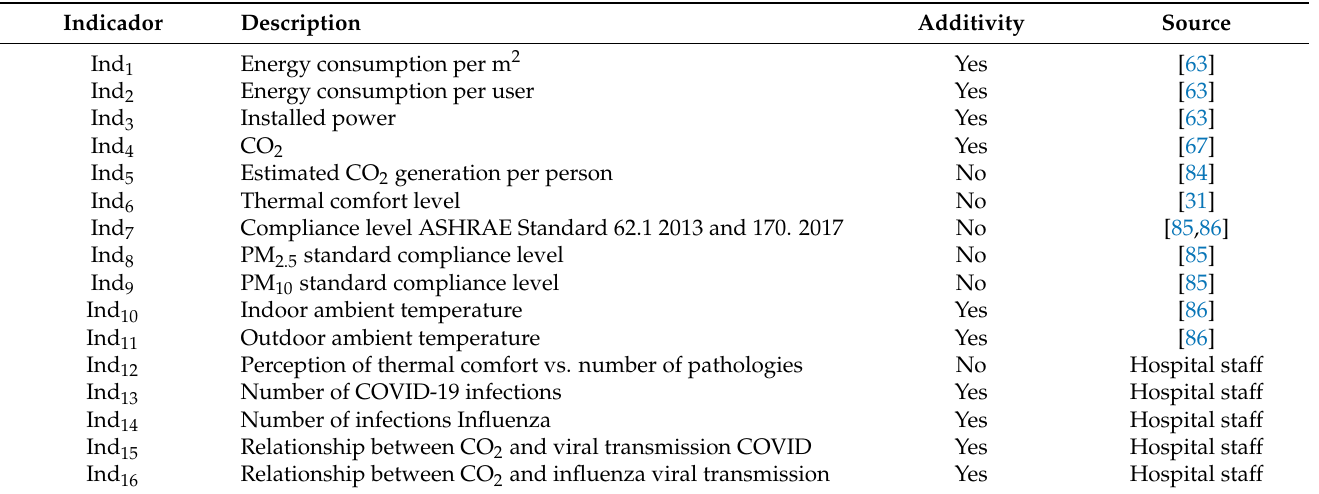
Table 2. System indicators.